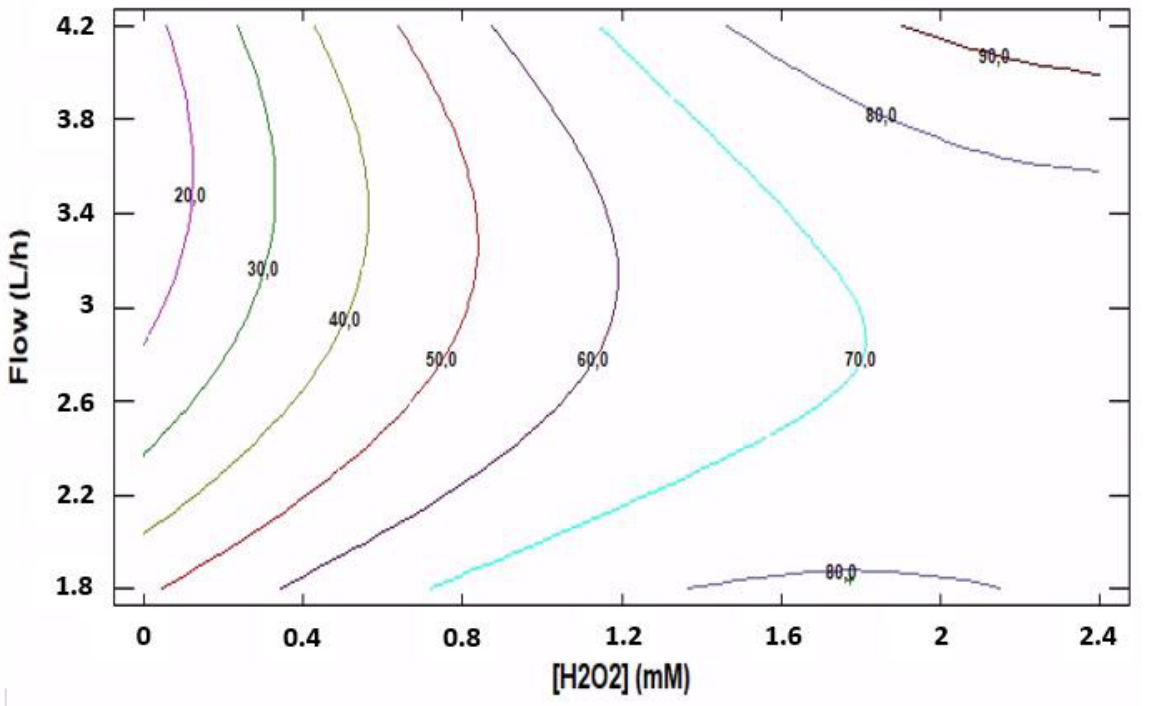
Figure 6. Surface response obtained for the removal of acetaminophen in continuous mode. The % of removal at the exit of the reactor is plotted vs. the concentration of H 2 O 2 and the flow rate.